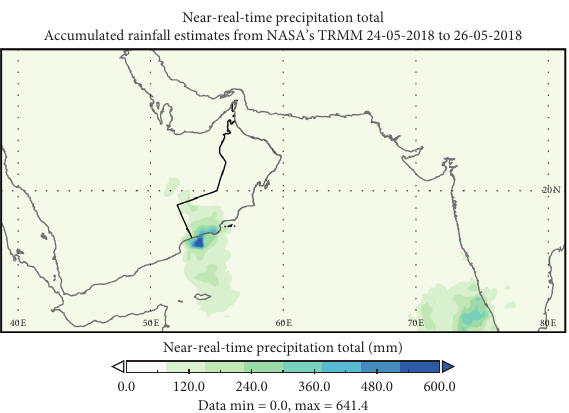
Figure 19: Accumulated rainfall estimates from NASA’s TRMM satellite for 3 days (24–26 May